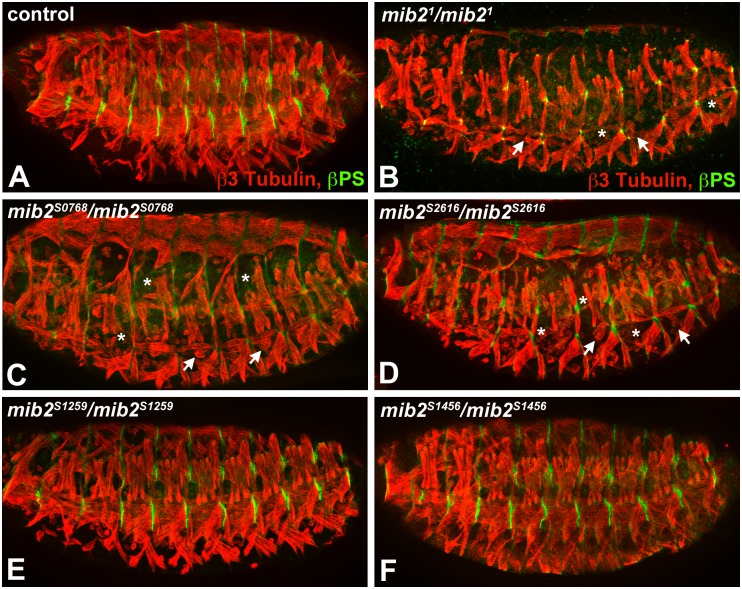
mib2S0768 and mib2S2616 mutant embryos have severe somatic muscle defects.(A-F) Late stage embryos were double-labeled with antibodies against β3-Tubulin (red) and βPS integrin (green) to visualize the muscles and attachment sites, respectively. As compared to the control embryo (A), missing (asterisks) or detaching (arrows) muscles are readily detectable in homozygous mib21 (B), mib2S0768 (C), and mib2S2616 (D) mutant embryos. Homozygous mib2S1259 (E) and mib2S1456 (F) mutant embryos exhibit a normal somatic musculature.